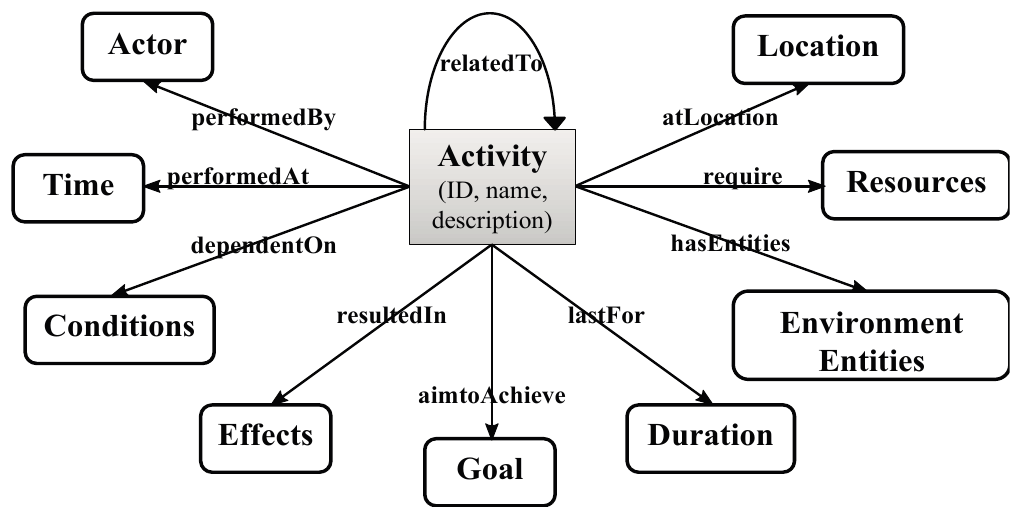
Figure 3. Conceptual description of an activity characterization (based on